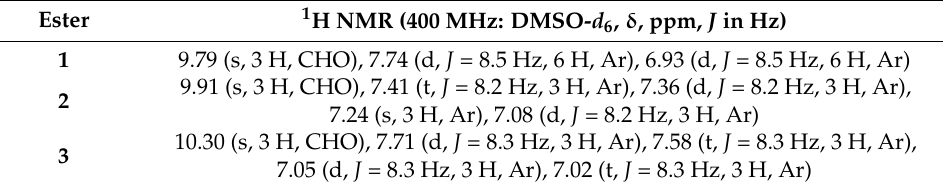
Table 2. 1 H NMR spectral data for phosphate esters 1 – 3 .